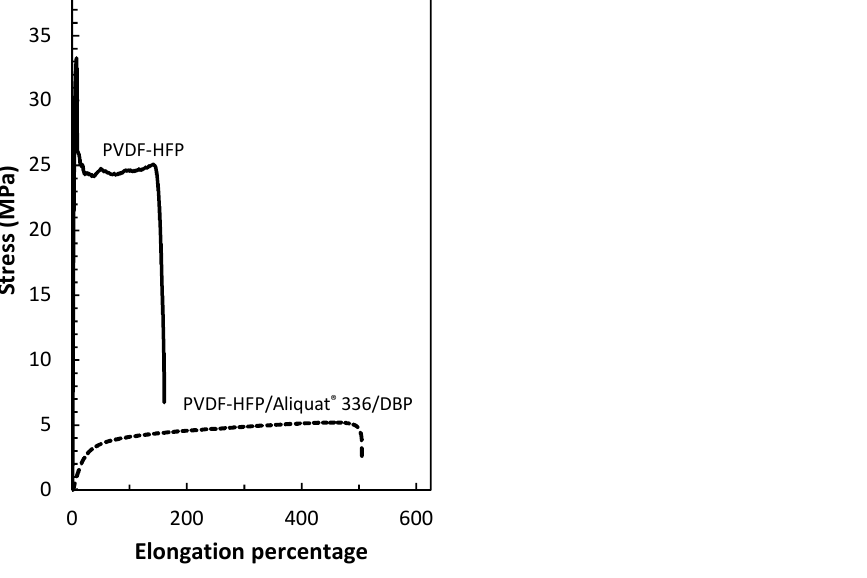
Figure 14. Stress–strain diagrams for the PVDF–HFP film and the optimized PIM (50 wt% PVDF-HFP, 40 wt% Aliquat ® 336 and 10 wt% DBP).